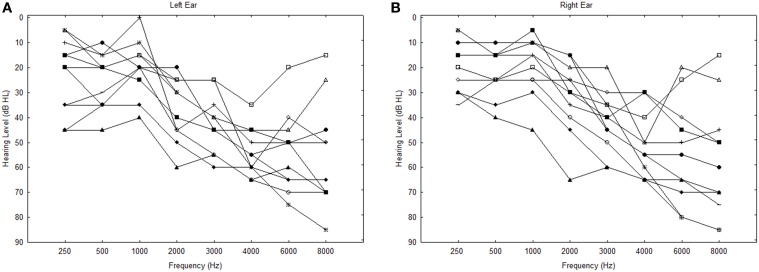
Hearing thresholds for the left (A) and right (B) ears of the OHI subjects in Experiment 2.